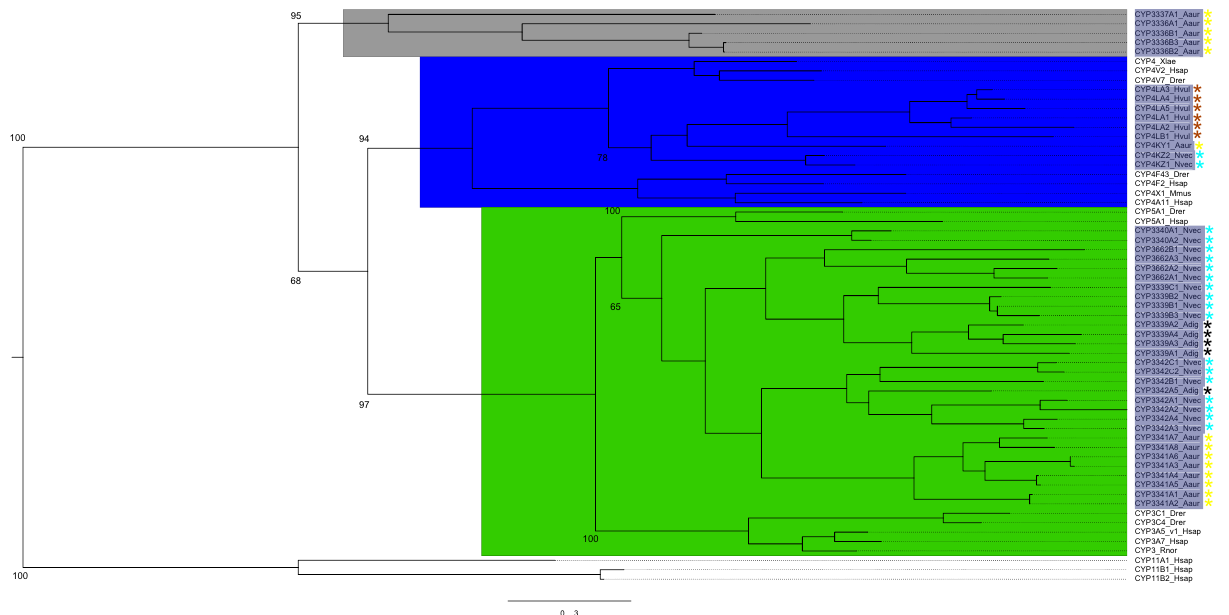
Figure 5. Maximum-likelihood phylogenetic tree of cnidarian clan 3 and clan 4 cytochrome P450 enzymes. The tree was generated with rapid bootstrapping and a gamma distribution with the JTT substitution matrix. The Clan 3 CYPs are light green, the Clan 4 CYPs are dark blue, and the CYPs that do not fall within a clan are grey. The cnidarian CYP names are highlighted in dark grey on the tree. The different coloured asterisks